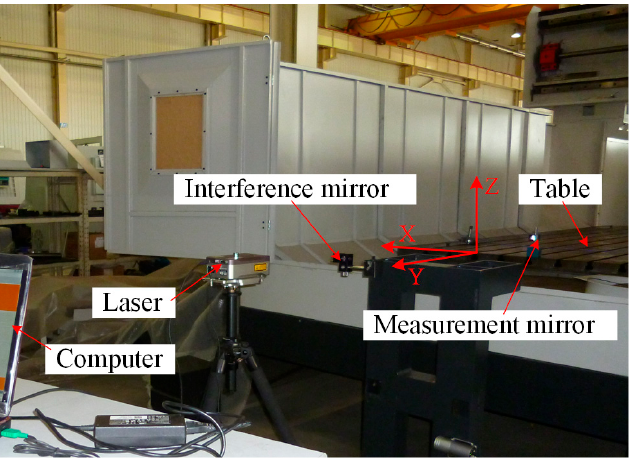
Figure 6. Displacement response measurement of the ball screw feed system in the feed direction.